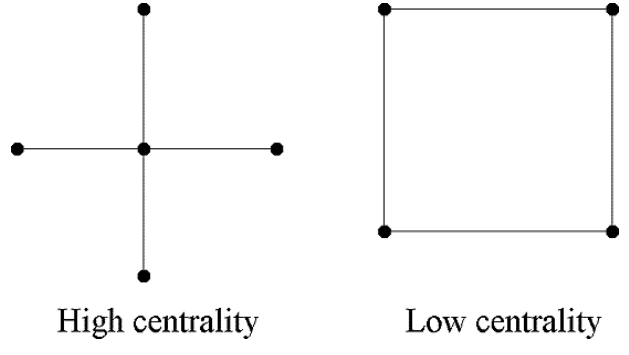
Fig. 2 . Two simple networks with different levels of